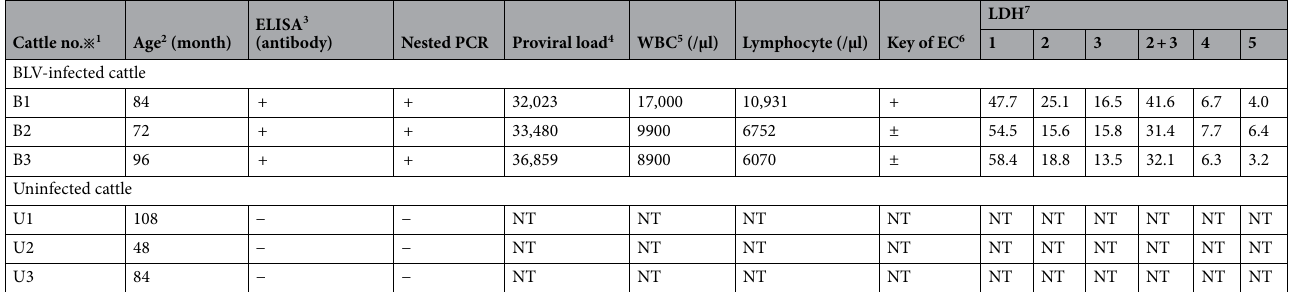
Table 1. Clinical status of BLV-infected and uninfected cattle. + , positive; -, negative; ± , suspect; NT, not tested; 1 no., number; 2 Age at the time of blood sampling; 3 ELISA, anti-BLV antibody enzyme-linked immunosorbent assay; 4 copies/10 5 WBCs DNA; 5 WBCs, white blood cells; 6 Key of EC, leucosis-key of the European Community; 7 LDH, lactate